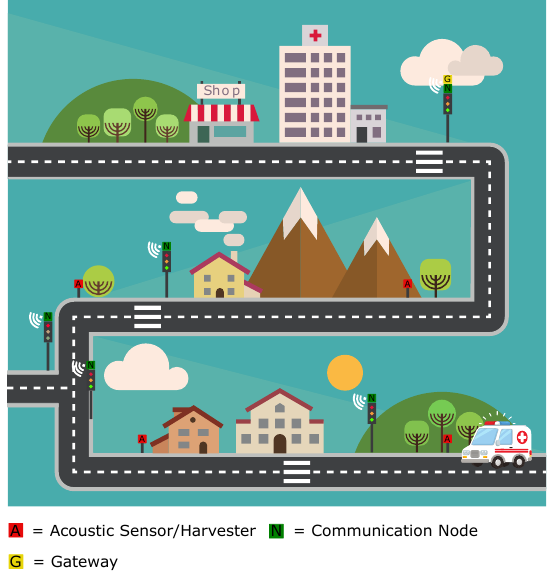
Figure 12. Application scenario (background image: Freepik.com).